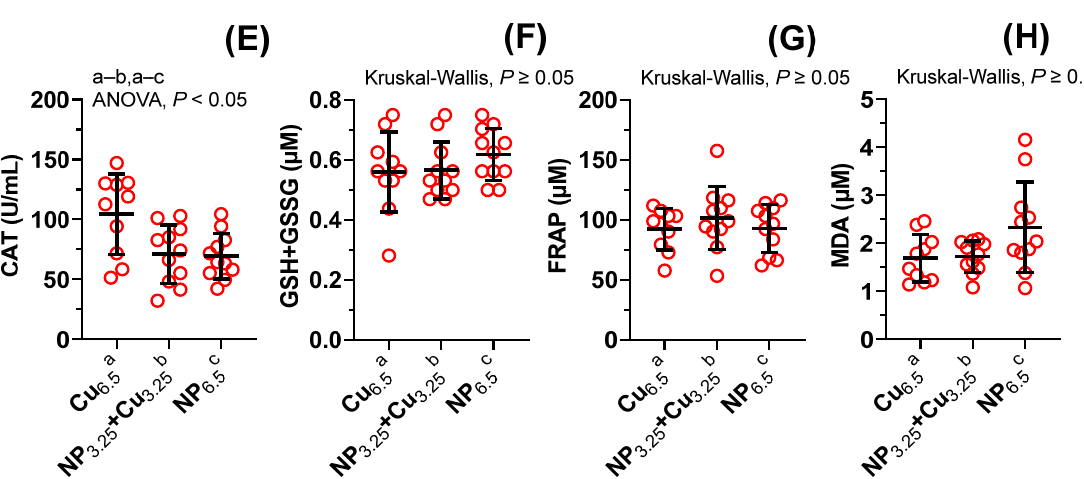
Figure 2. The influence of experimental diets on Cu, Zn content ( A – C ), and antioxidant mechanism ( D – H ) in blood plasma. Values are expressed as means ± SD of n = 11 rats. Supplementation with NP 6.5 decreased the Cu ( × 0.7), Cu/Zn-ratio ( × 0.6), catalase (CAT, × 0.7), and increased Zn ( × 1.2), and superoxide dismutase (SOD, × 1.4). NP 3.25 + Cu 3.25 decreased the Cu/Zn-ratio ( × 0.7), and CAT ( × 0.7).